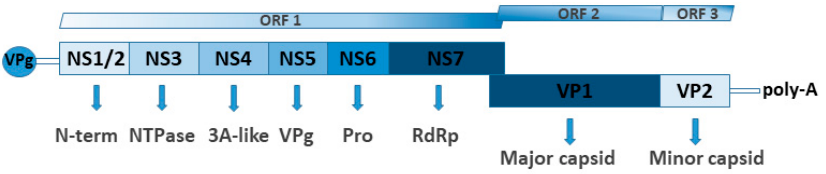
Figure 2. Genome organization of norovirus.